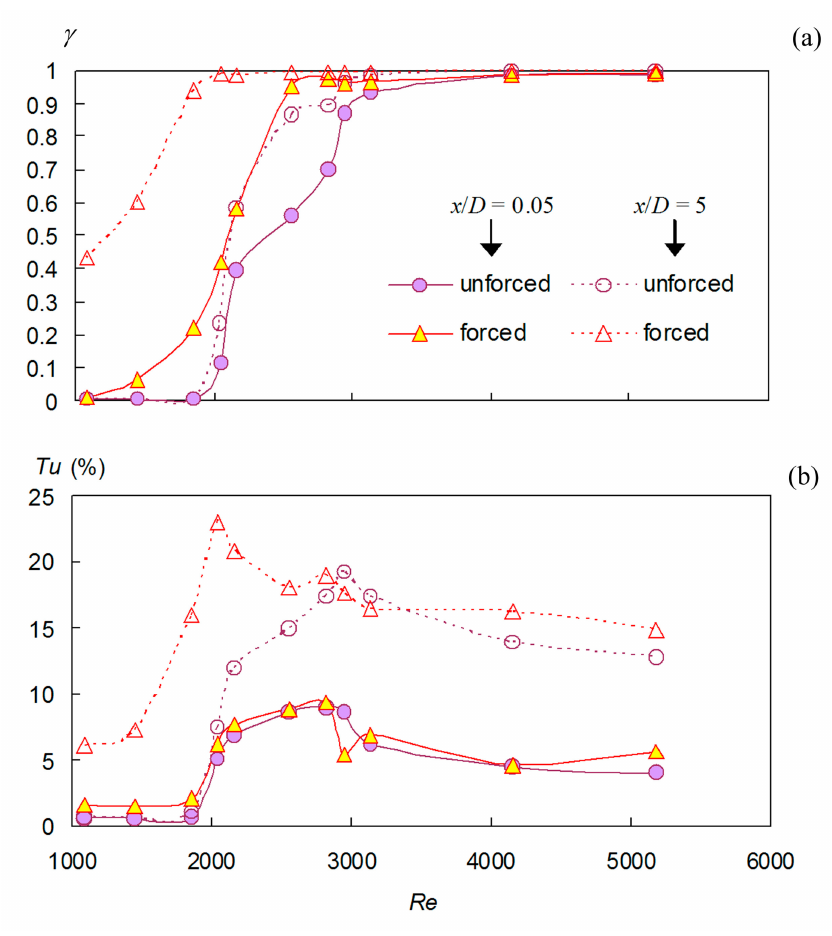
Figure 7. Jet quantities evaluated at x/D = 0.05 and 5 for Re = 1081–5181: ( a ) intermittency factor; ( b ) intensity of